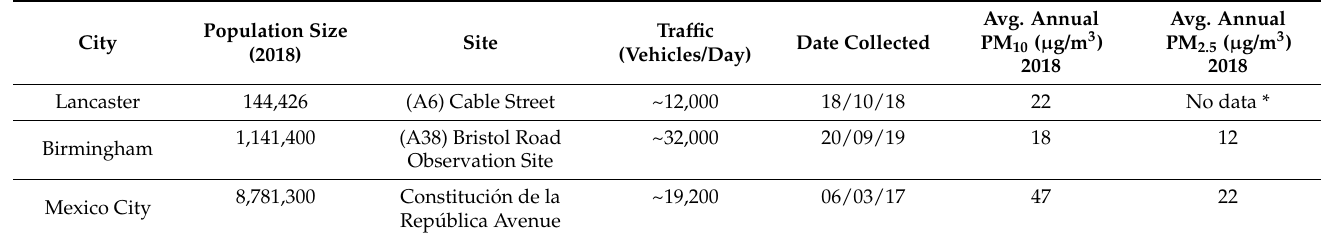
Table 1. Road-deposited dust sample collection sites. * The Cable Street monitoring station in Lancaster started measuring PM 2.5 from October 2020. An approximate average for Lancaster PM 2.5 is 8 µ g/m 3 based on data available at http://www.ukairquality.net/ (accessed on 5 November 2021). PM data obtained from [62–64], population data from